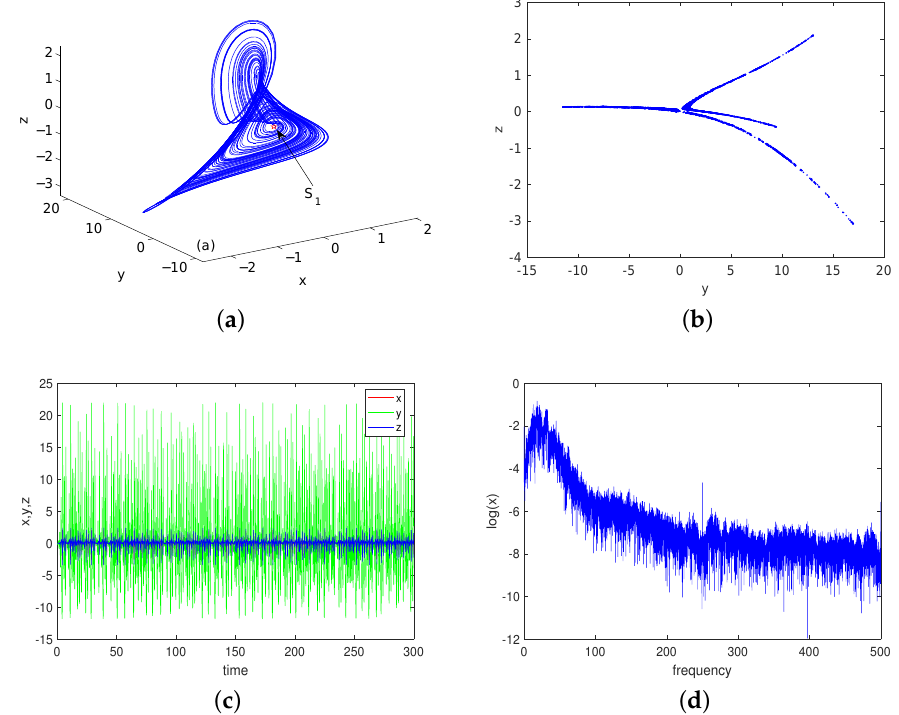
Figure 1. ( a ) Chaotic attractor of system (1) with ( a , b , c , d ) = ( 0.4,60,16,10 ) at the initial values ( 0.01,0.01,0.01 ) T . ( b ) The corresponding Poincaré map on plane x = 0. ( c ) The time series of the x , y , z states. ( d ) The power spectrum of the x